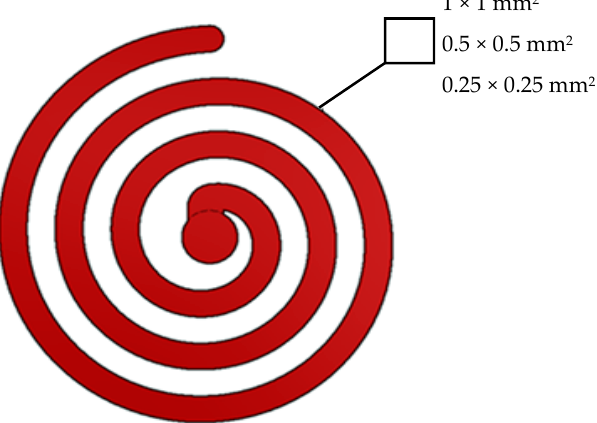
Figure 1. Spirals with different cross sections.